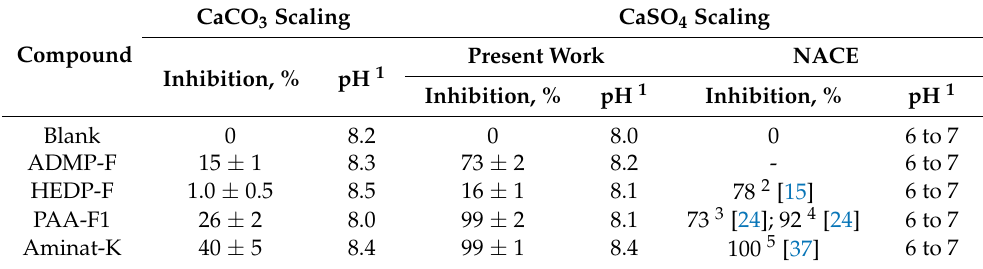
Table 2. Scale inhibition in slow saturation runs at 10 mg · dm − 3 antiscalant dosage. CaCO 3 Scaling CaSO 4 Scaling Compound Present Work NACE Inhibition, % pH 1 Inhibition, % pH 1 Inhibition, % pH 1 Blank 0 8.2 ADMP-F 15 ± 1 HEDP-F PAA-F1 26 ± 2 Aminat-K 40 ±